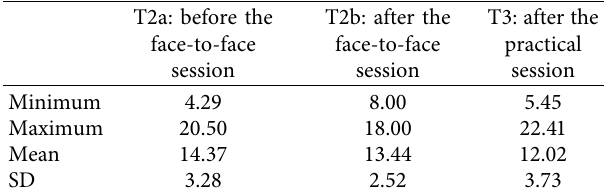
Table 3: Time required for the knowledge level tests at diferent